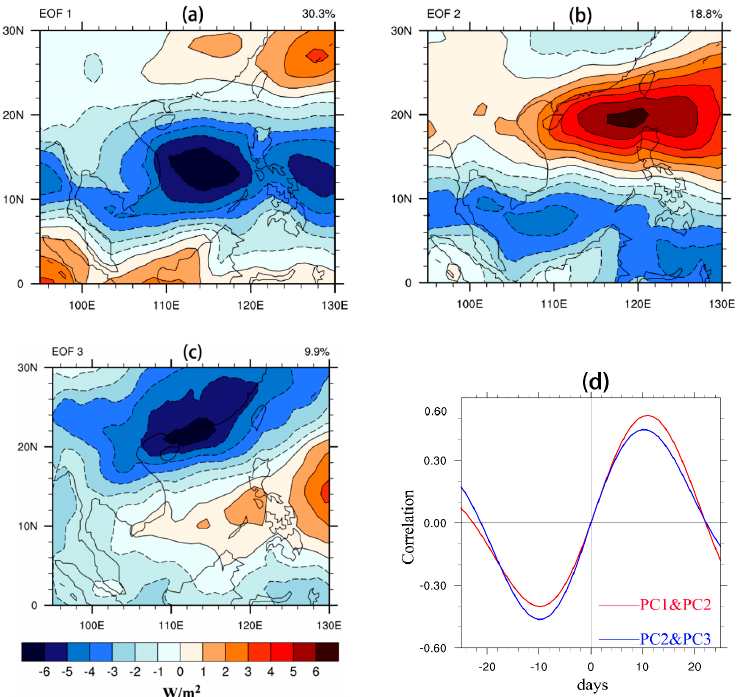
Figure 1. Three leading empirical orthogonal function (EOF) modes ( a ) EOF1, ( b ) EOF2, and ( c ) EOF3 of 30~60-day bandpass filtered daily OLR anomalies over the SCS for 1996~2016; ( d ) is the cross-correlation of PC1-PC2 (red solid line) and PC2-PC3 (blue solid line).